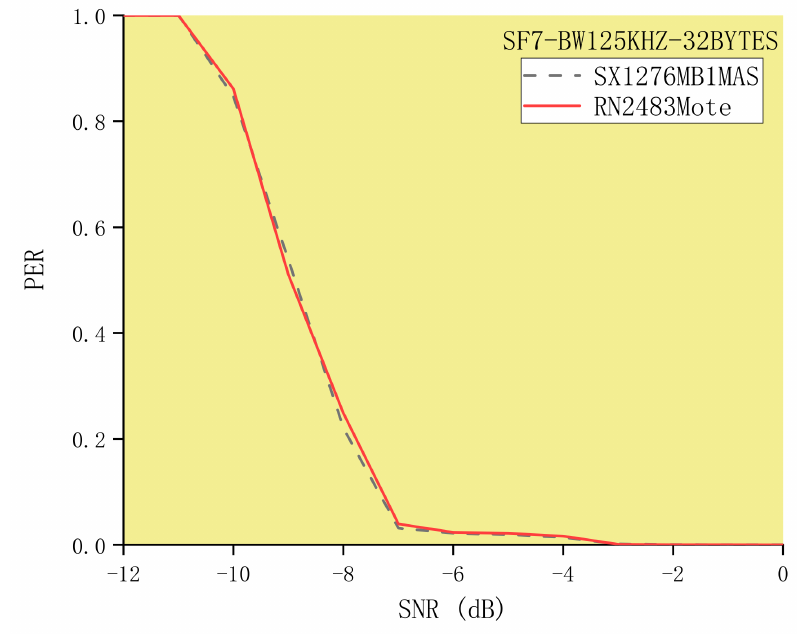
Figure 10. Measurement results of different LoRa receivers (SX1276MB1MAS and RN2483